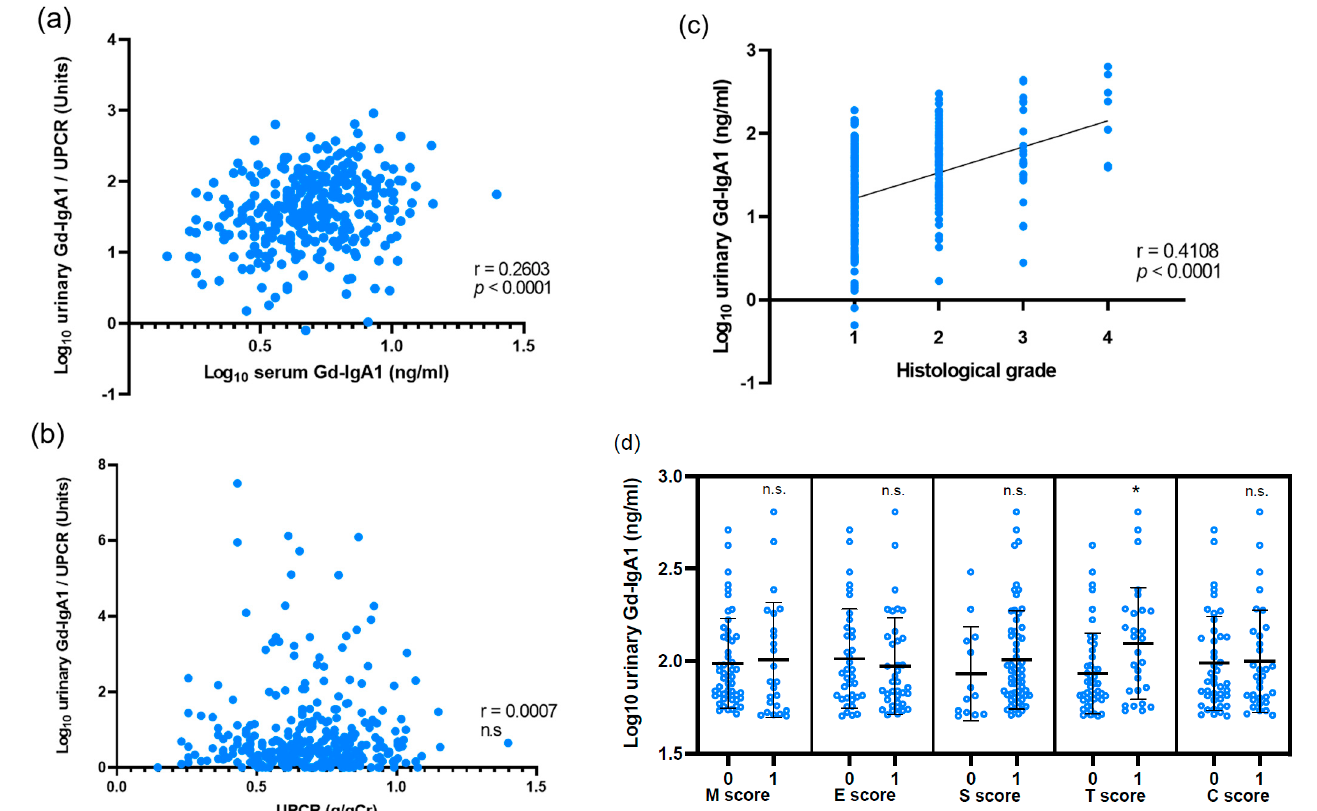
Figure 2. Correlation between urinary Gd-IgA1 and laboratory and pathological findings in IgAN patients from the Japanese cohort. ( a ) The levels of urinary Gd-IgA1 associated with the levels of serum Gd-IgA1. ( b ) The levels of urinary Gd-IgA1 did not correlate with the levels of proteinuria. ( c ) Urinary Gd-IgA1 levels were positively correlated with the histological grade. ( d ) Urinary Gd- IgA1 levels were positively correlated with the T score of the Oxford classification in cases with urinary Gd-IgA1 greater than 50 ng/mL. * p < 0.01, n.s.: not significant, Abbreviations: M (mesangial hypercellularity); E (endocapillary hypercellularity); S (segmental glomerulosclerosis); T (tubular atrophy/interstitial fibrosis); and C (cellular/fibrocellular crescents).